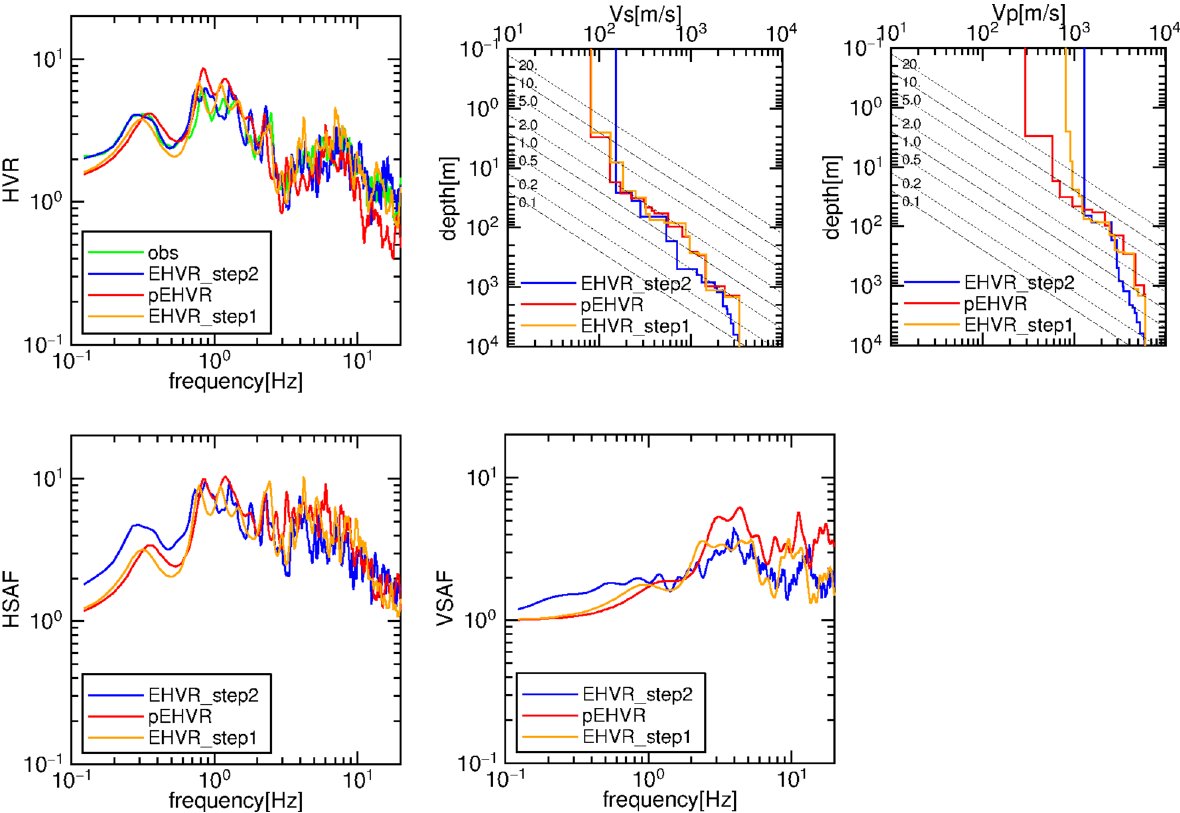
Fig. 7 Comparisons of the theoretical EHVRs by the inverted models with the observed EHVR (top row on the left) and the resultant S- and P-wave velocity profiles (top row on the right side). The red and blue lines are the results of the velocity models inverted for the converted pEHVR and the observed EHVR in Step-2 labelled as “EHVR_step2”, respectively, while the green line in the top row on the left is the observed EHVR. Orange lines are those of the inverted velocity model using the same parameters as in pEHVR labelled as “EHVR_step1”. In the bottom row, comparisons of the theoretical HSAFs and VSAFs from the velocity models inverted for the converted pEHVR (red) and the observed EHVR in Step-2 (blue), together with those of the inverted velocity model using the same parameters as in pEHVR, which are shown in the top row (orange). Please note that the red and blue lines are the same as those in Figs. 5 and